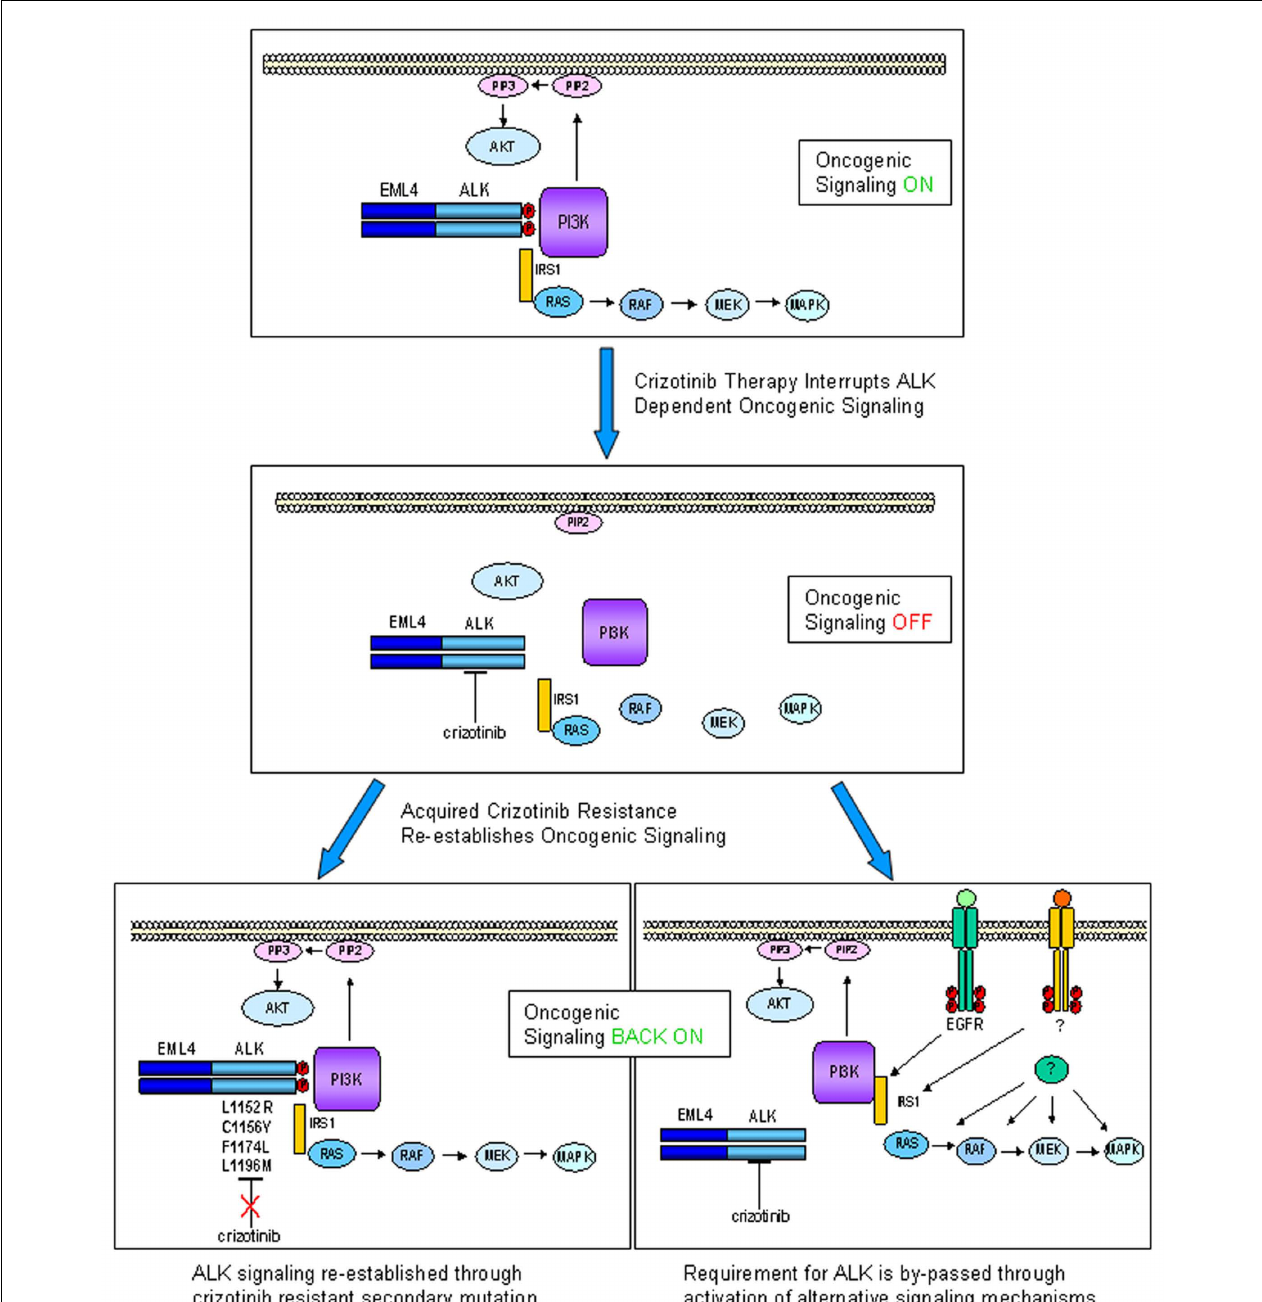
which abrogate ability of crizotinib to inhibit its kinase activity (some known clinically relevant mutations are indicated). For this type of resistance second-generation ALK inhibitors might be particularly effective. In ALK-independent acquired resistance, activation of alternative signaling pathways (e.g., EGFR, c-MET, or downstream signaling components) occurs collateral to ALK activation, removing the absolute requirement for ALK as a driver oncogene. In this case, it can be hypothesized that ALK is still present and inhibited by drug, so that combination therapy with an ALK inhibitor would be a therapeutic